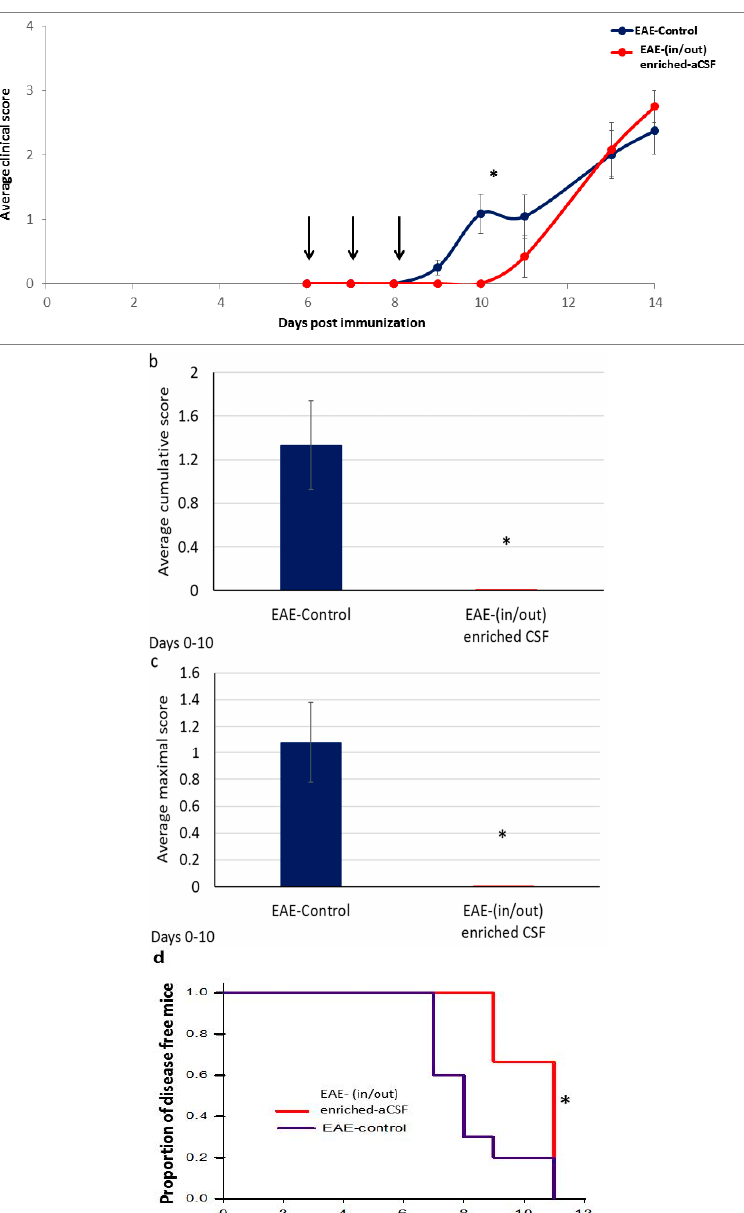
Figure 4. Short-term enriched-aCSF (in/out) exchange therapy shows a short-term amelioration of the EAE clinical symptoms. Experimental autoimmune (EAE)-mice treated with in/out MSC secretions enriched-aCSF (enriched-aCSF) exchange therapy delivered at days 6–8 following EAE-induction showed a trend of lower average clinical EAE-score at days 9–11 post EAE-induction (repeated ANOVA (f(1,16) = 3.73, p = 0.07)). ( a ) with a significant difference in the average clinical score at day 10 between the treated and untreated mice ( t -test, p = 0.012). While untreated mice developed the disease already at day 9, treated mice developed it only at day 11 following induction (arrows represent days of treatment); ( b ) A significantly lower average cumulative score at days 0–10 post EAE-induction ( t -test, p = 0.017) was detected in the treated mice relative to the untreated EAE-control; ( c ) A significantly lower average maximal score at days 0–10 post EAE-induction, ( t -test, p = 0.012) was detected in the treated mice. From days 12–13 (i.e., 4–5 days after the end of therapy) the graphs of the average score of treated and untreated mice merged, and no significant differences were found in the cumulative and maximal scores; ( d ) Using the Kaplan Meier analysis revealed significant less EAE disease-free mice among the treated mice relative to the untreated (Log-Rank Test: p = 0.028), with the median values for the 50% chances to stay free of disease symptoms was at day 11 for the treated and at day 8 for the untreated